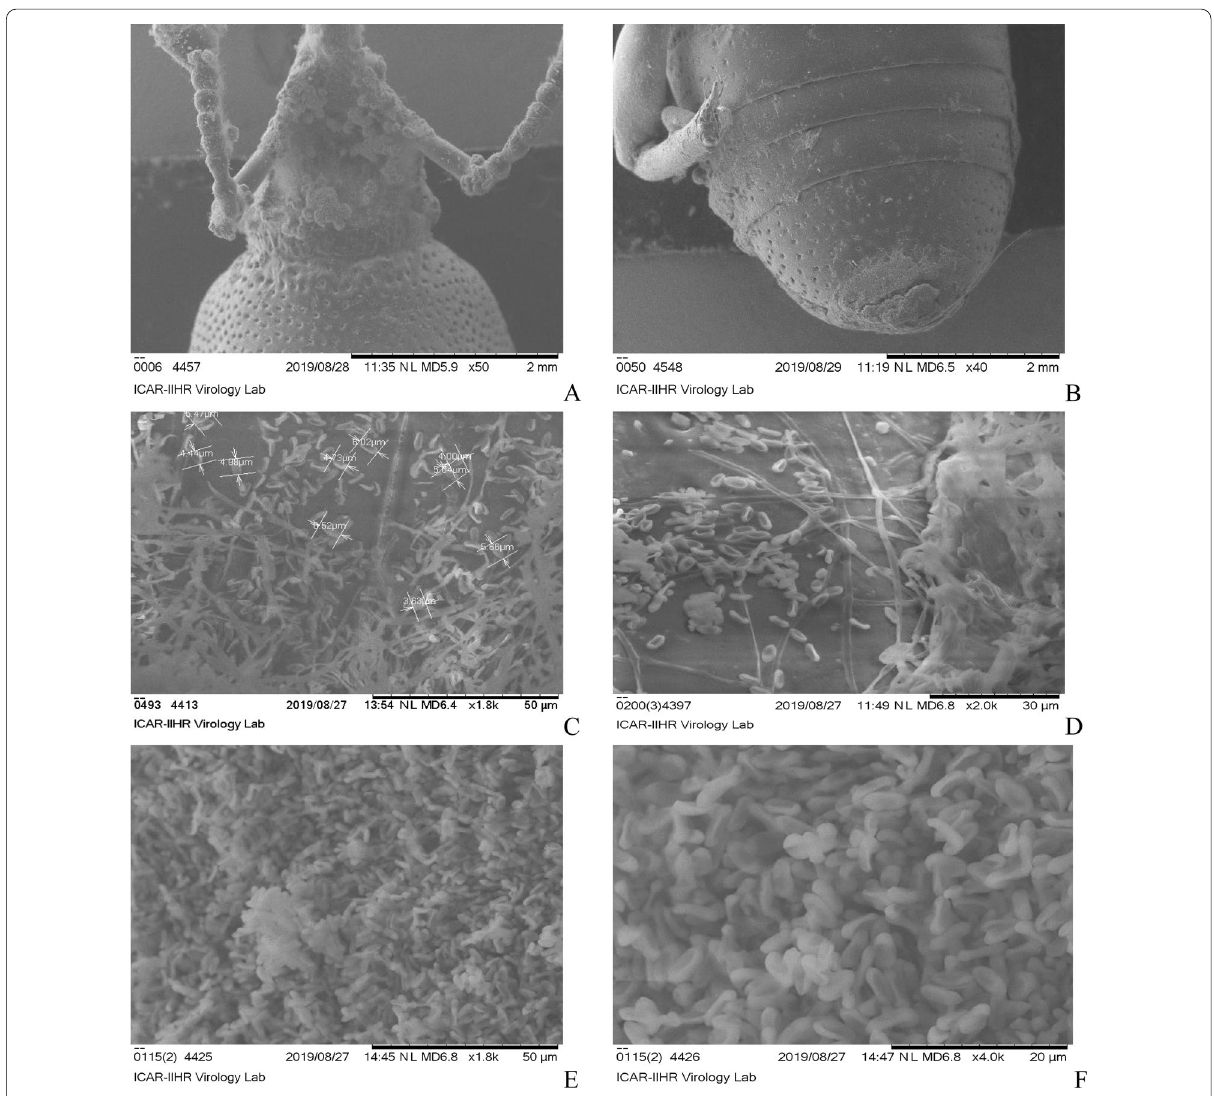
Fig. 2 SEM image showing the process of Metarhizium quizhouense infection in Odoiporus longicollis . A , B Conidia adhered to the surface of adults insect (2 mm), C , D the cuticle surface of the insect of hyphae (scale par 50 µm & 30 µm), E , F large amount formed in mycelia of M. quizhouense (scale par 50 µm & 20